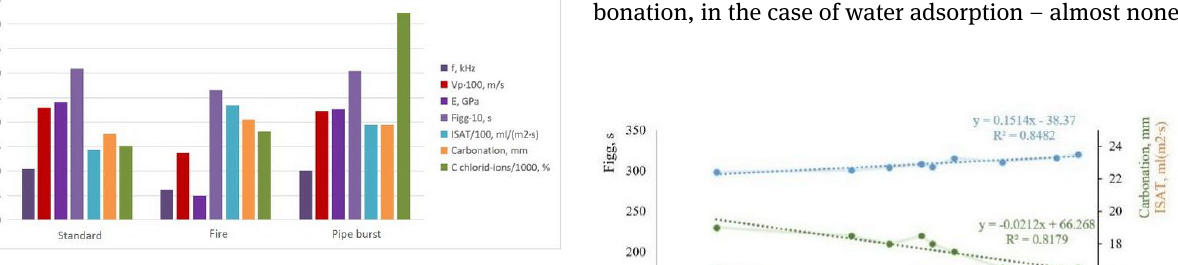
Figure 1: Summary histogram of the results of five experiments.